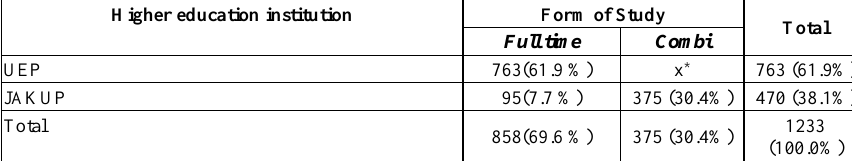
Table 2. Structure of the research sample – form of